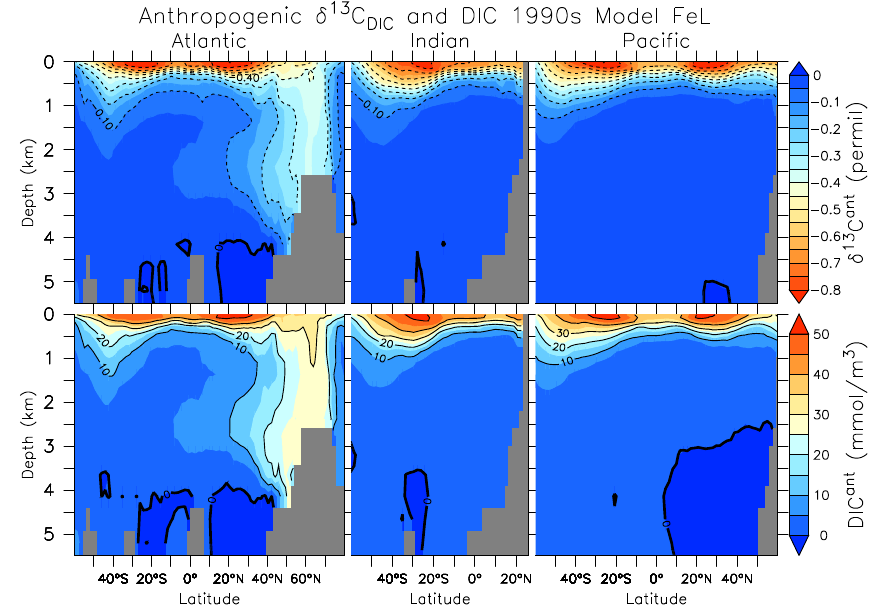
Fig. 14. Anthropogenic δ 13 C (top) and carbon (bottom). Isoline difference is